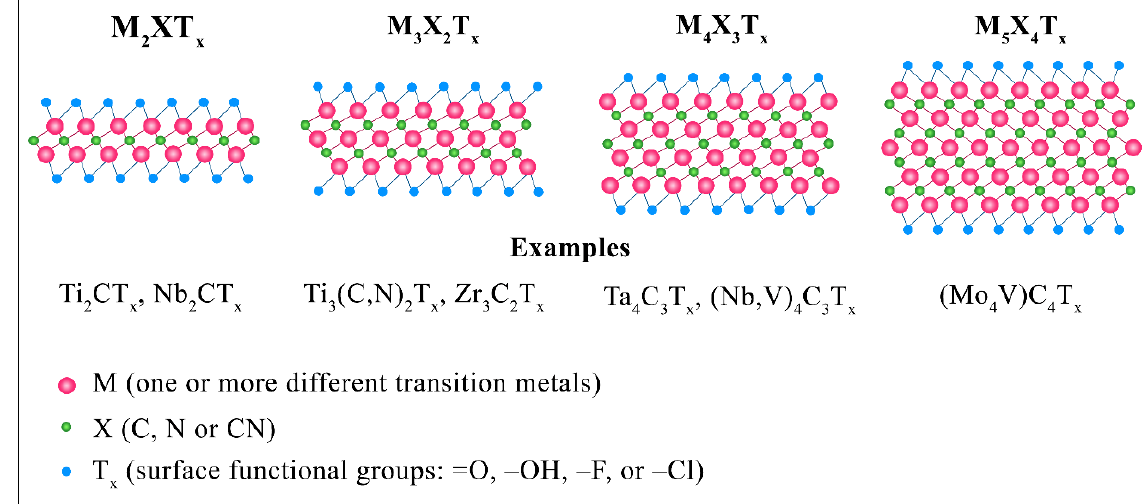
Figure 21. Schematic representation of the structure of MXenes with n = 1–4 and some examples. Additionally, as mentioned above, there are out-of-plane ((M (cid:48) 2 , M (cid:48)(cid:48) )AlC 2 or (M (cid:48) 2 , M (cid:48)(cid:48) 2 )AlC 3 ) and in-plane ((M (cid:48) 2/3 , M (cid:48)(cid:48) 1/3 )AlC) MAX phases, which can be etched to